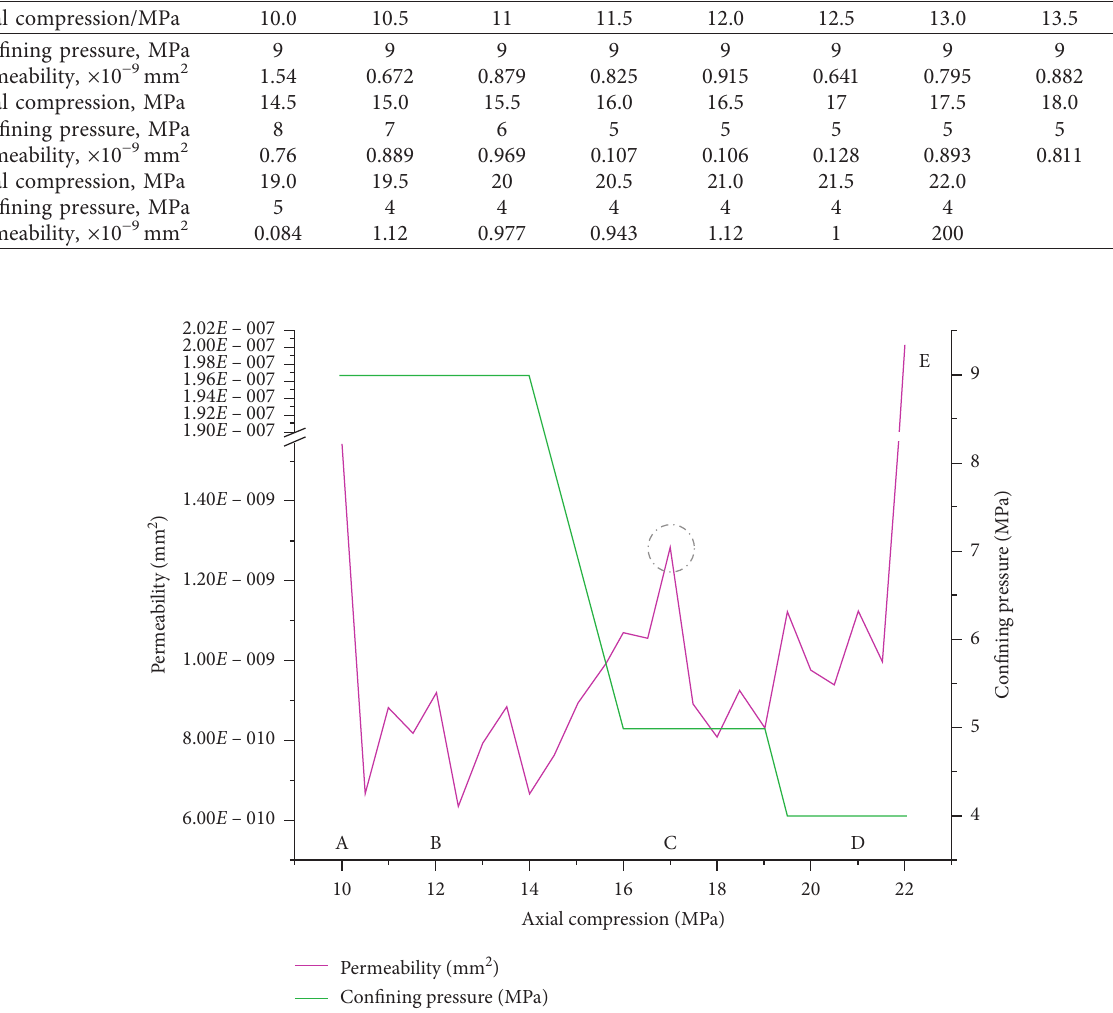
Table 1: MD-1 sandstone loading path and permeability